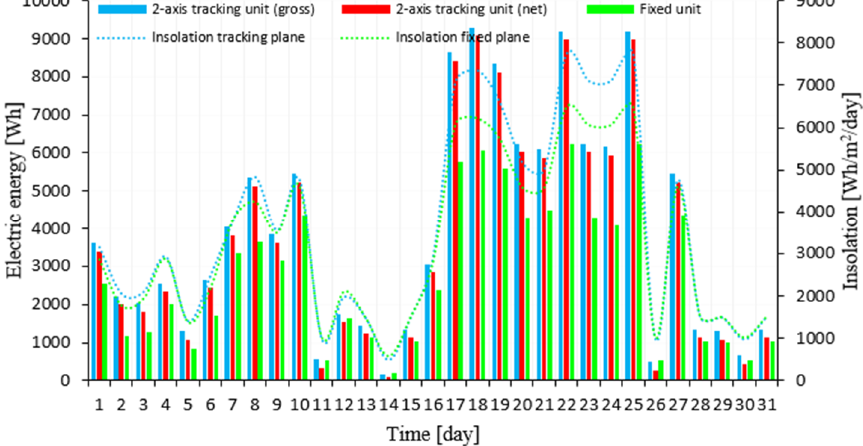
Figure 17. Variability of the electricity production and the determined insolation for photovoltaic modules in the fixed